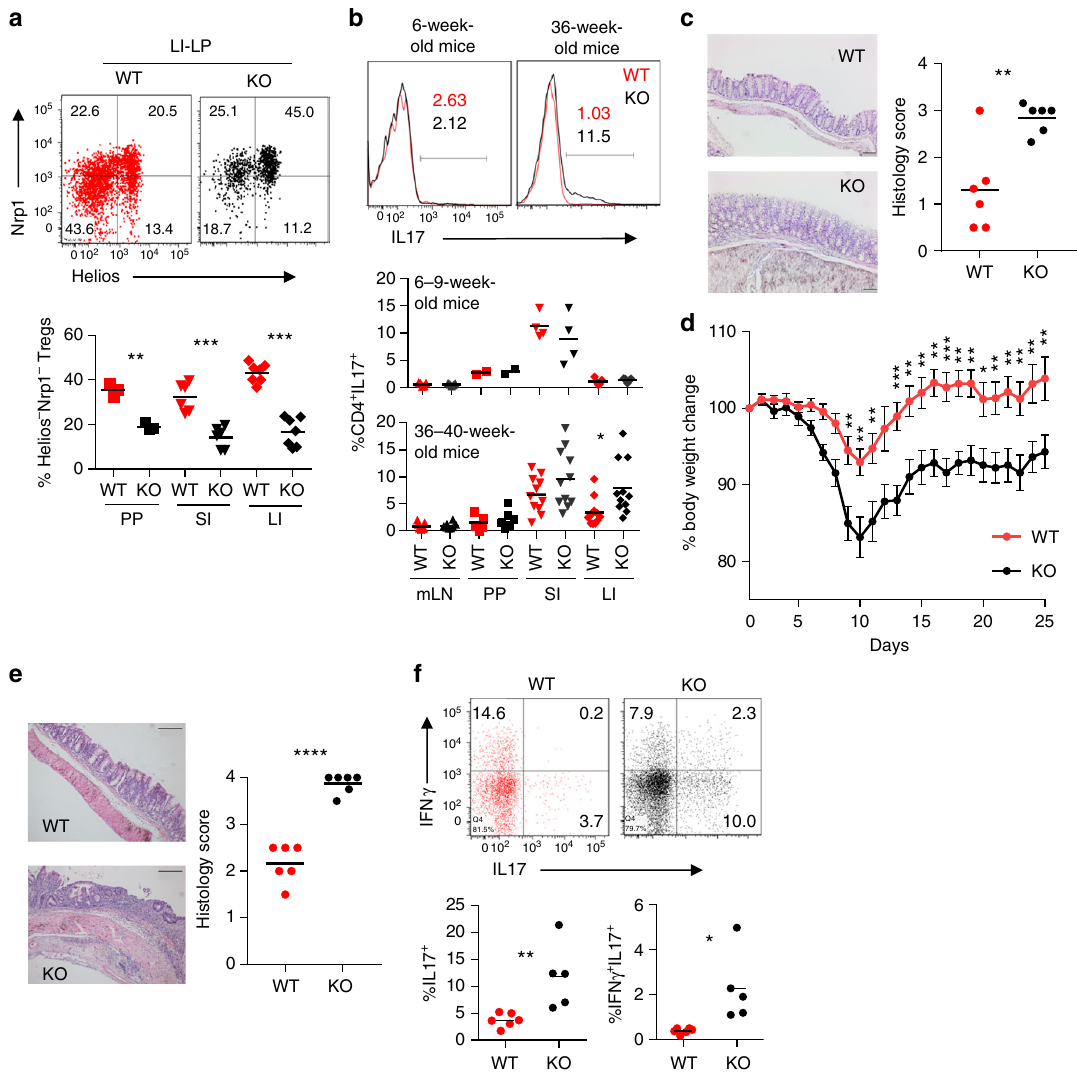
Fig. 7 In fl ammation in the intestinal mucosa of Foxp1 f/f Foxp3 IRES-YFP-Cre mice. a Representative fl ow cytometric analysis from LI-LP (top) and quanti fi cation (bottom) of Foxp3 + Nrp1 − Helios − iTreg population within GALT tissues from WT and KO mice. b Representative fl ow cytometric analysis from LI-LP (top) and quanti fi cation of percentage of IL17-producing CD4 + Foxp3 − cells in 6 – 9-week- (middle panel) and 36 – 40-week-old (lower panel) WT and KO mice. c Representative histological sections (left) and histological scoring (right) of colon from aged WT and KO mice. Sections were stained with hematoxylin and eosin. Original magni fi cation ×100, scale bar equals 100 µ m. d Susceptibility of WT and KO mice to 2% DSS-induced chronic model of colitis. Body weight loss over time is presented as a read out of disease severity. Two-way ANOVA with Bonferroni post-test was applied and statistically signi fi cant differences in mean values is considered at P < 0.05. Data are representative of two experiments ( n = 10 for each group). e Histological sections (left) and scoring (right) of colon from representative DSS-treated WT and KO mice. Sections were stained with hematoxylin and eosin. Original magni fi cation ×100, scale bar equals 100 µ m. f Intracellular staining and quanti fi cation of colonic IFN- γ - and IL17-producing CD4 + Foxp3 − cells from representative DSS-treated mice. PP Peyer ’ s patches, SI small intestine, LI large intestine, mLN mesenteric lymph nodes. Data are representative of 2 – 4 independent experiments. * P < 0.05, ** P < 0.01, *** P < 0.001, **** P <0.0001 (Student ’ s t test, error bars,